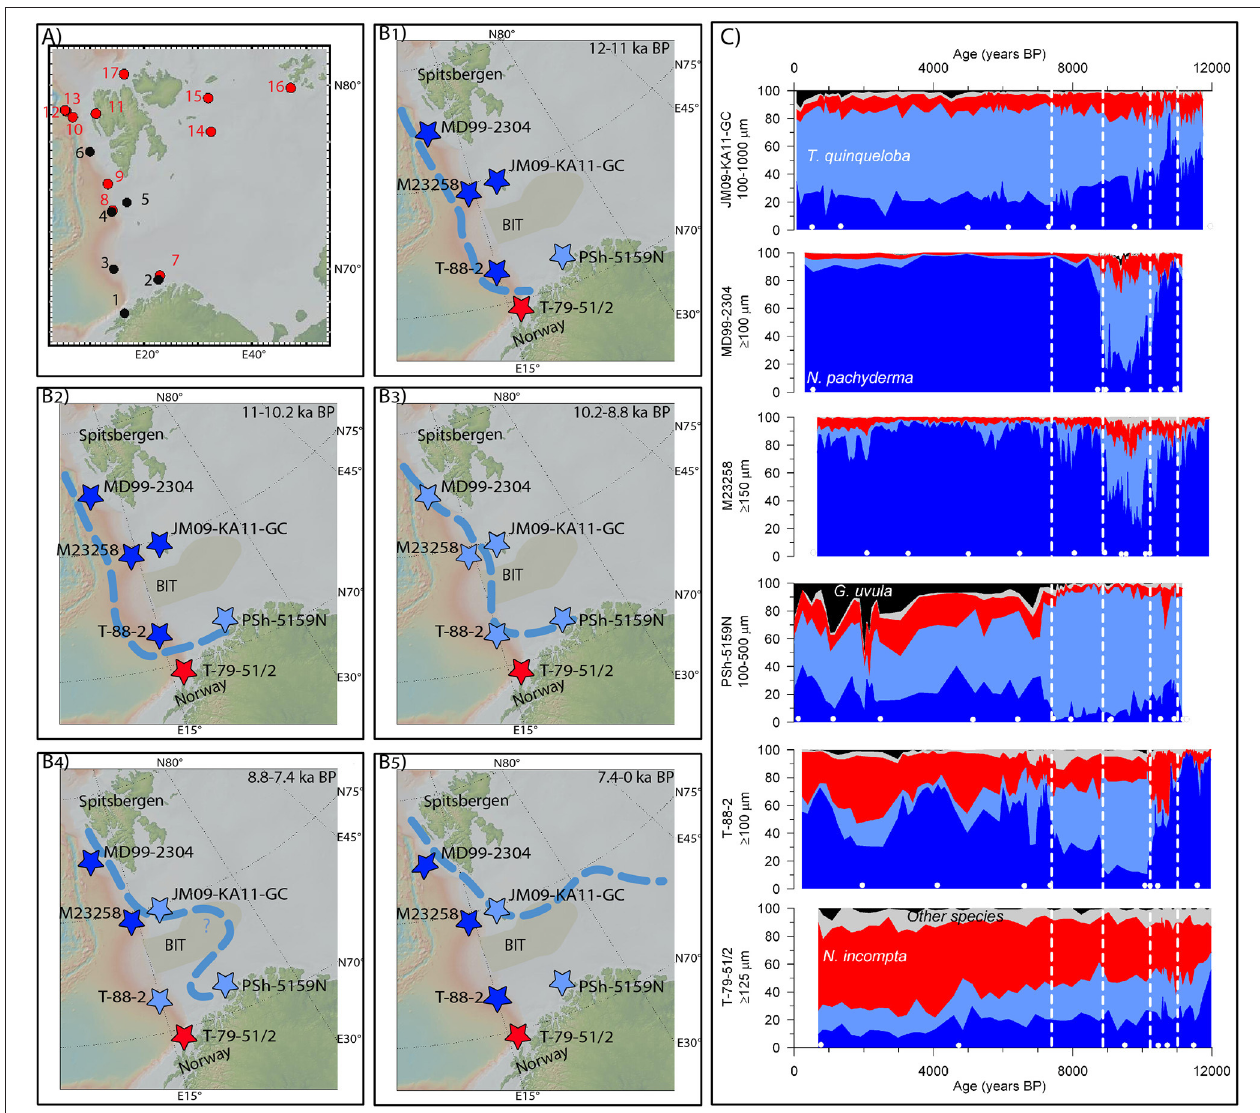
FIGURE 2 | (A) Map showing the location of the investigated cores (black) and cores from other studies mentioned in the discussion (red). (1) T-79-51/2 (Hald et al., 1996). (2) PSh-5159N (Risebrobakken et al., 2010). (3) T-88-2 (Hald and Aspeli, 1997; Hald et al., 2007). (4) M23258 (Sarnthein et al., 2003). (5) JM09-KA11-GC (Berben et al., 2014). (6) MD99-2304 (Ebbesen et al., 2007). (7) JM05-085-GC (Aagaard-Sørensen et al., 2010). (8) SV-04 (Rigual-Hernández et al., 2017). (9) JM03-373PC2 (Rasmussen et al., 2007). (10) MSM5/5-712-2 (Müller et al., 2012; Werner et al., 2013; Aagaard-Sørensen et al., 2014). (11) NP05-71GC (Rasmussen et al., 2014). (12) JM10-330GC (Consolaro et al., 2018). (13) MSM5/5-723-2 (Müller et al., 2012; Werner et al., 2016). (14) NP05-11-70GC (Belt et al., 2015; Berben et al., 2017). (15) NP05-71GC (Klitgaard-Kristensen et al., 2013). (16) ASV880 (Duplessy et al., 2001). (B) Location of the investigated cores. The color of the star marking the location is defined by the dominant planktic foraminiferal species (dark blue: N. pachyderma ; light blue: T. quinqueloba ; red: N. incompta ; black: G. uvula ; light gray: other species) of each individual site during the different time intervals ( B 1 : 12–11 ka BP. B 2 :11–10.2 ka BP. B 3 : 10.2–8.8 ka BP. B 4 : 8.8–7.4 ka BP. B 5 : 7.4–0 ka BP). The light blue stippled line indicates the location of the BSAF during the different time intervals represented by (B 1 − 5 ) . (C) Relative abundance of planktic foraminifera at the investigated sites over the last 12 ka BP. The color coding for the species is the same as in (B) . The stippled white lines indicate the transition phases between the time intervals of (B 1 − 5 ) . The white dots at the bottom of each panel indicate the tie-points for the age models that are within the 0–12 ka BP interval. Full information about all tie-points available is given in Table 2 . Maps are created using GeoMapApp, http://geomapapp.org.